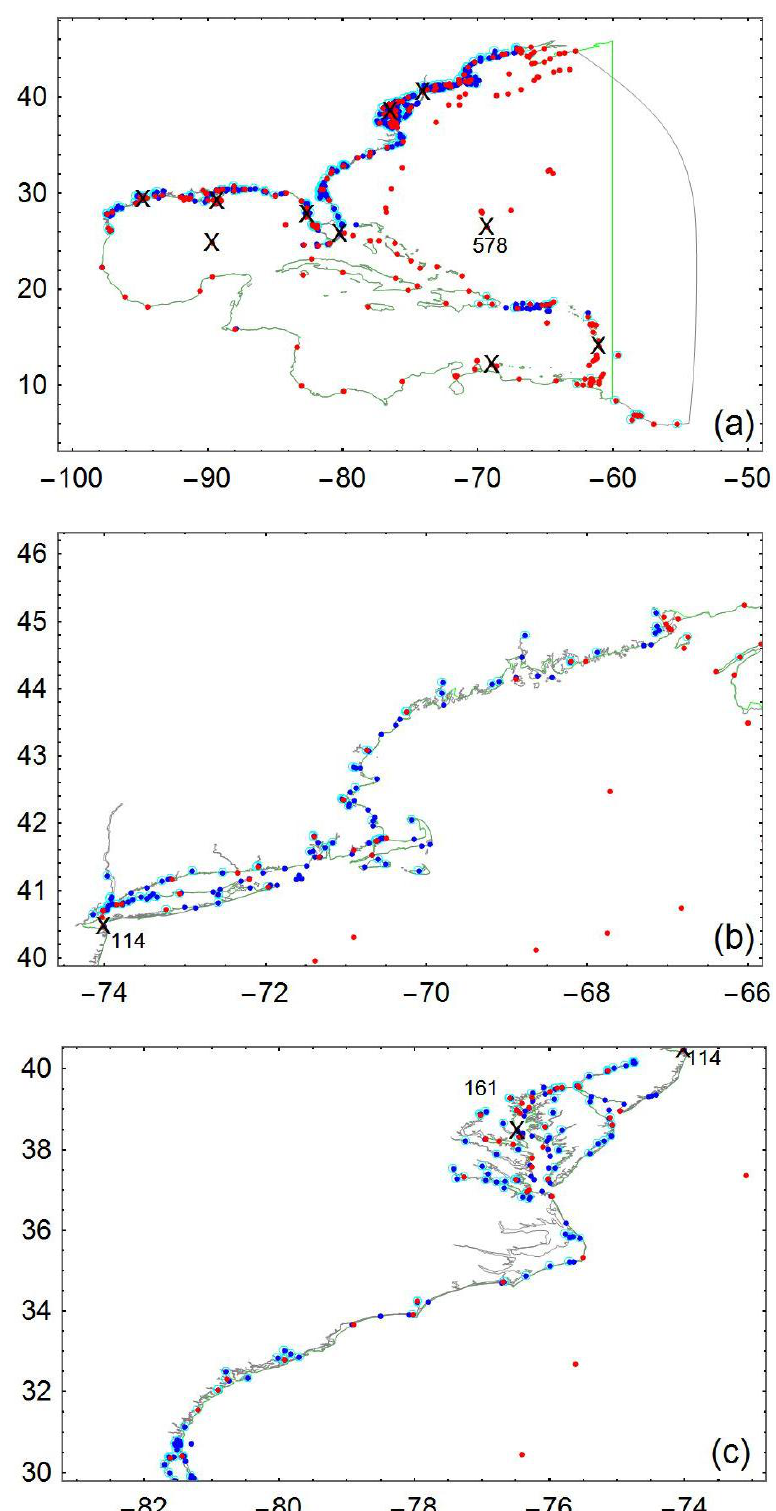
Figure 5. Locations for the stations available for validating the WNAT tidal databases: ( a ) global; ( b ) New York and Maine coast; and ( c ) Delaware down to Georgia. Blue points are from NOAA, red points are from IHO, cyan circles indicate stations that are in EC2015 (gray boundaries) but are not wet in EC2001 (green boundaries). Scatterplots are shown in Appendix B for points shown by an X.